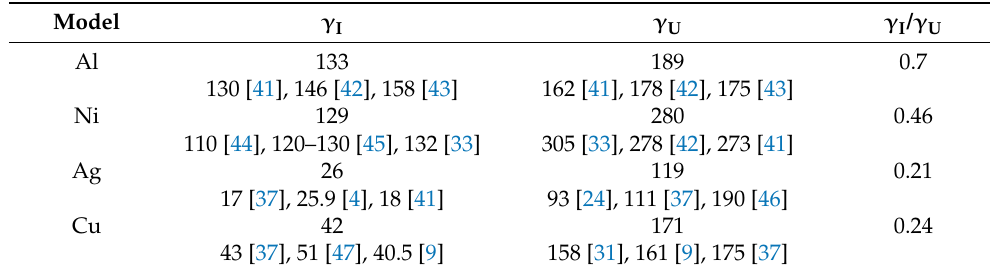
Table 3. The calculated γ I , γ U and the ratios of γ I / γ U of fcc Al, Ni, Ag and Cu. All values are in units of (mJ/m 2